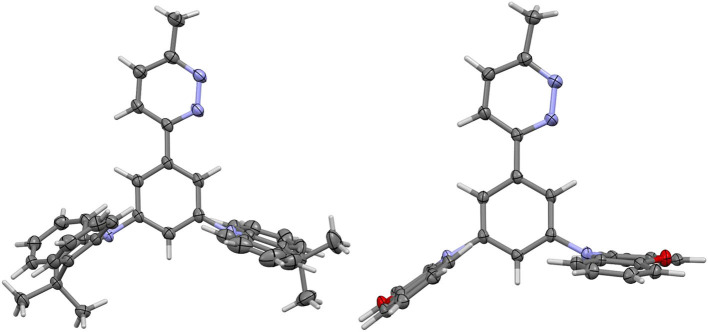
Thermal ellipsoid plots of the crystal structures of (left) dDMACMePydz and (right) one independent molecule of dPXZMePydz. Ellipsoids are drawn at the 50% probability level.